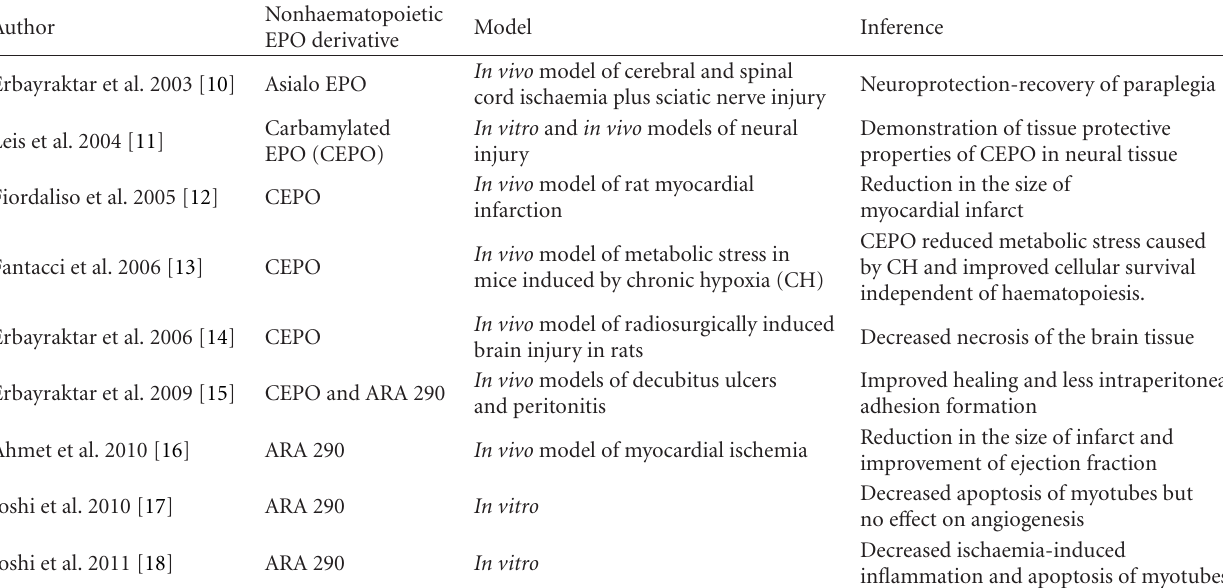
Figure 2: Schematic representation of the structure of erythropoietin receptor (EPOR) and beta-common receptor (CD131) on the left and the right hand side, respectively. ∗ Based on Brines et al. [29]. JAK-2 stands for Janus family Tyrosine Protein Kinase 2. Table 1: Recent studies investigating the role of nonhaematopoietic derivatives of